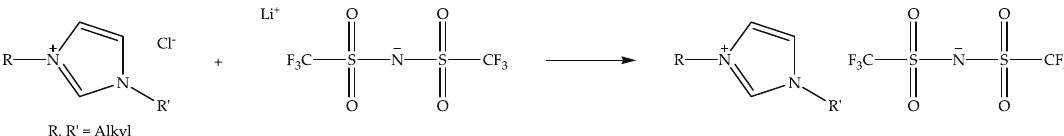
Figure 6: Schematic representation of the metathesis reaction of N - alkyl - N - alkylimidazolium chloride with lithium bis ( tri fl uoromethylsul - fonyl ) imide to synthesize the N - alkyl - N - alkylimidazolium bis ( tri fl uoromethylsulfonyl ) imide ionic